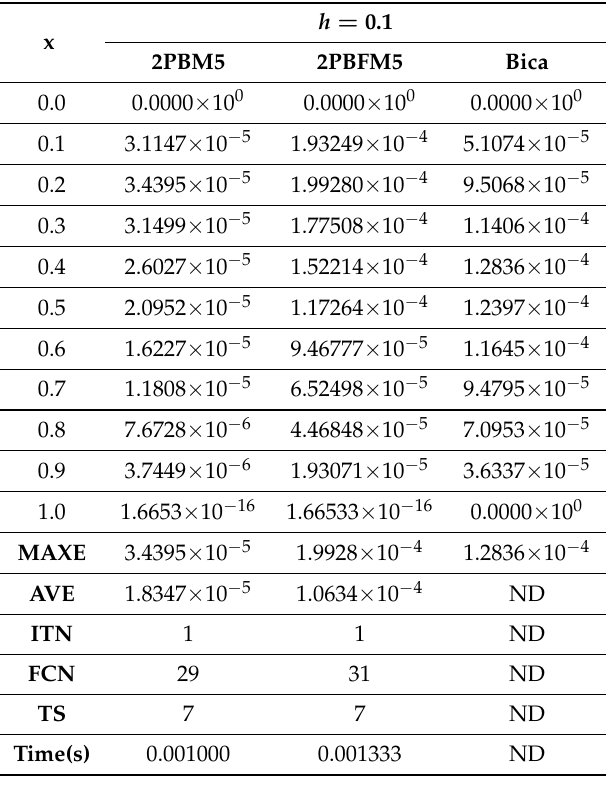
Table 2. The comparison results for Problem 2 at h = 0.1.